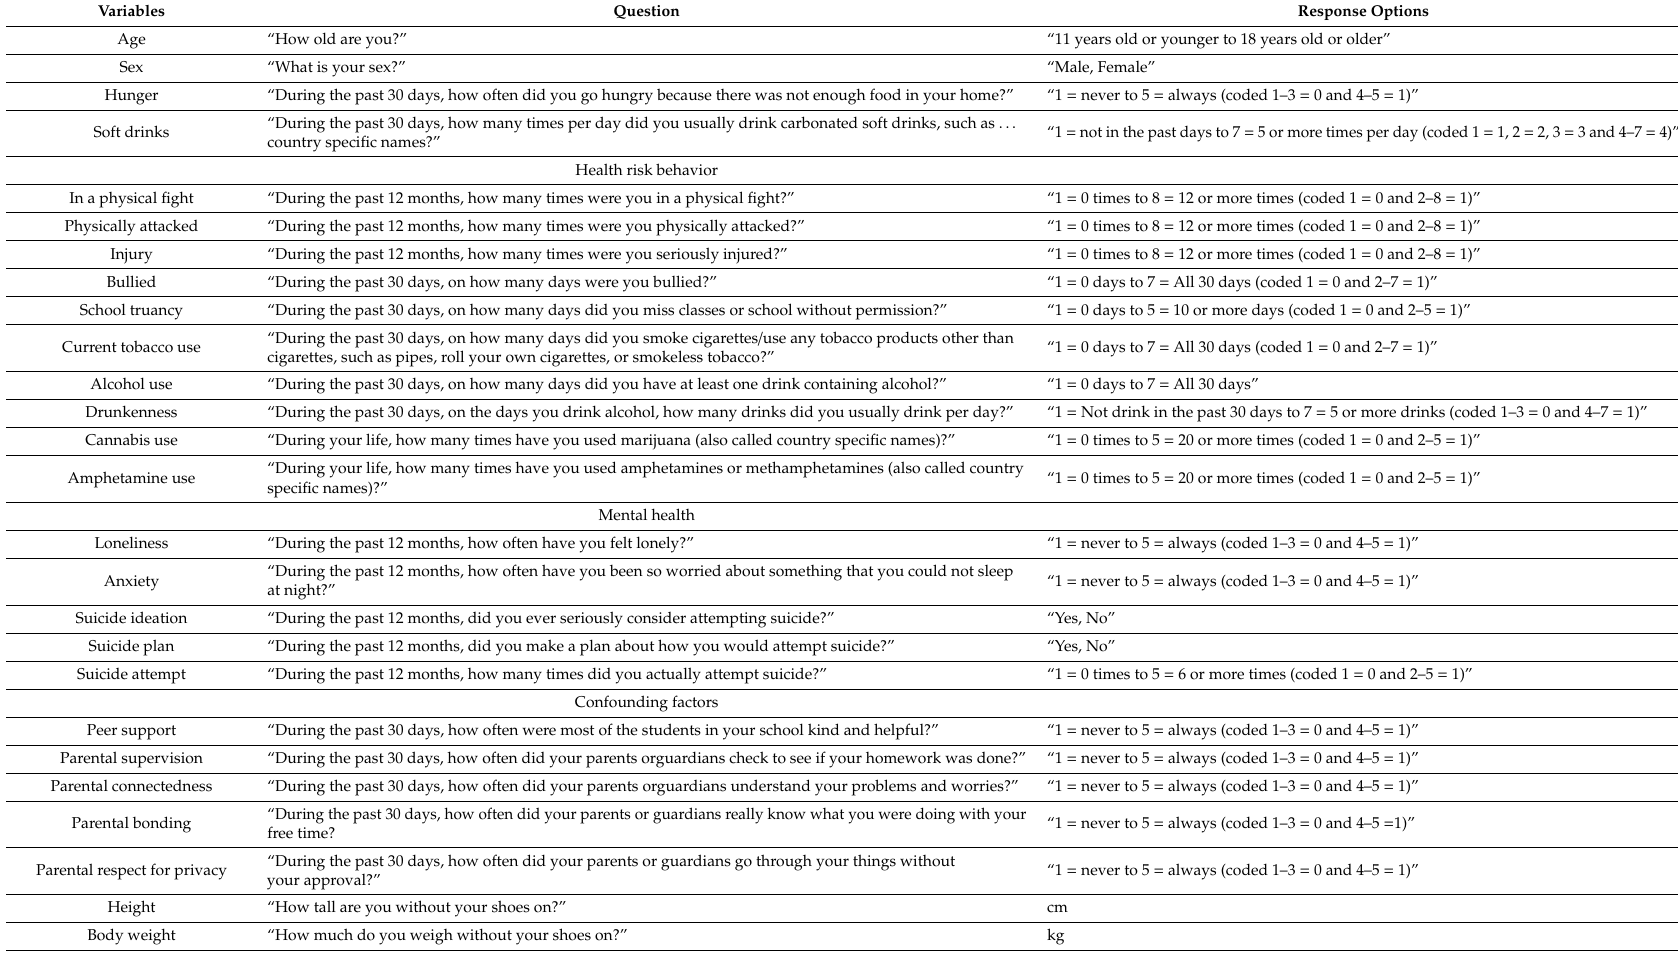
Table 1. Global school-based Student Health Survey variables, questions, and response options evaluated in this study of 2014–2015 respondents. Variables Question Response Options Age “How old are you?” “11 years old or younger to 18 years old or older” “What is your sex?” “Male, Female”